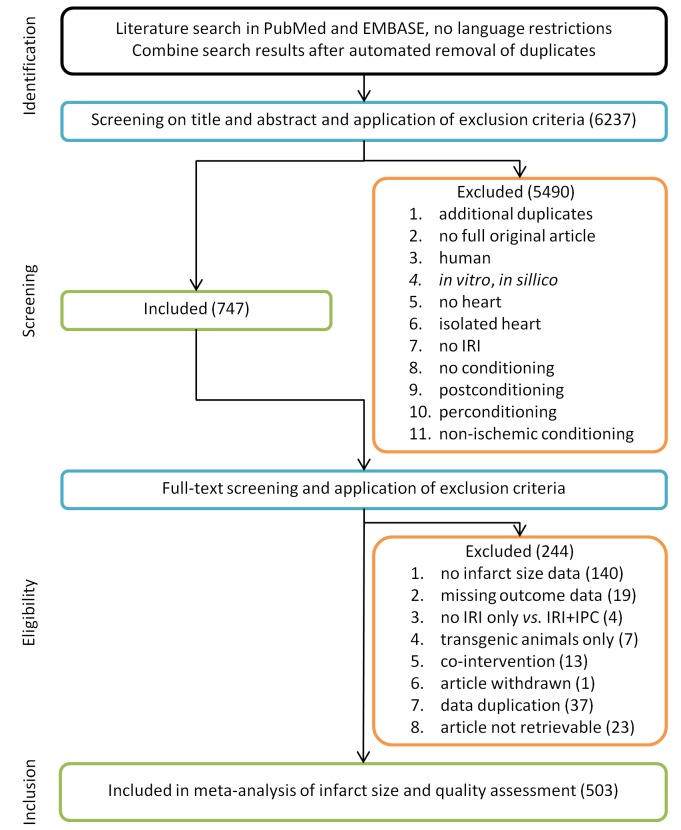
Flow chart of the study selection process.A systematic search in PubMed and EMBASE yielded 6237 unique publications. After application of inclusion and exclusion criteria, data from 503 publications were included in the meta-analysis and quality assessment.